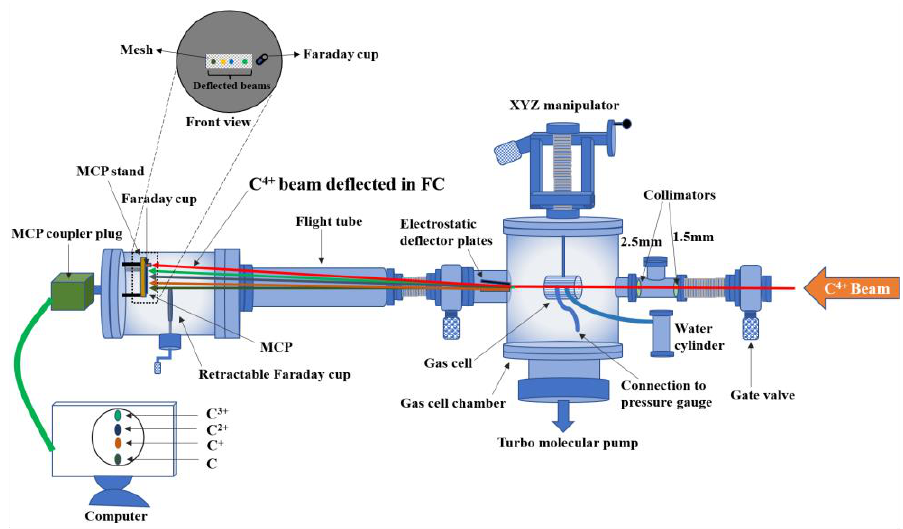
Figure 1. Schematic diagram of electron capture experimental setup. MCP: micro channel plate; FC: Faraday cup.